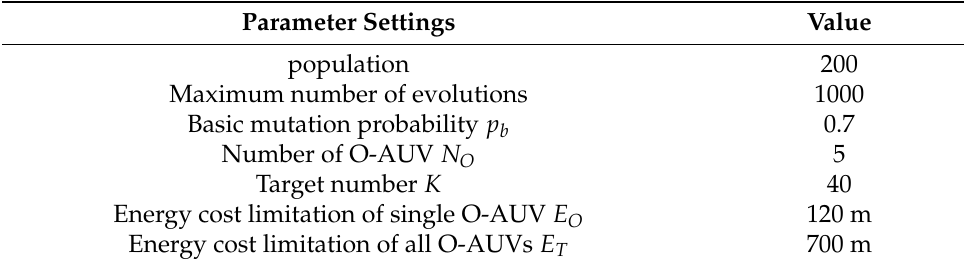
Table 3. Parameter settings of